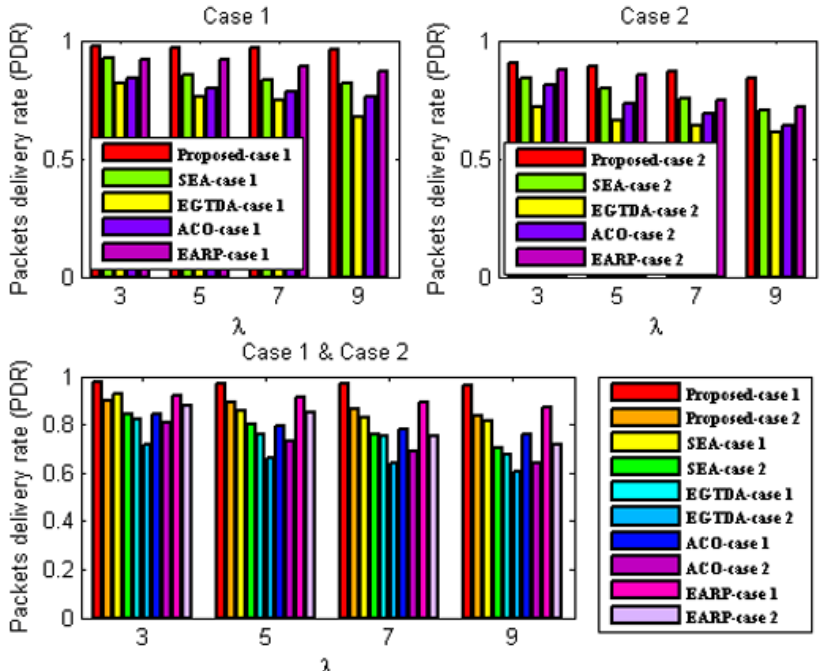
Figure 8. Influence of increasing average traffic rate on packets delivery ratio under the first sce- nario.